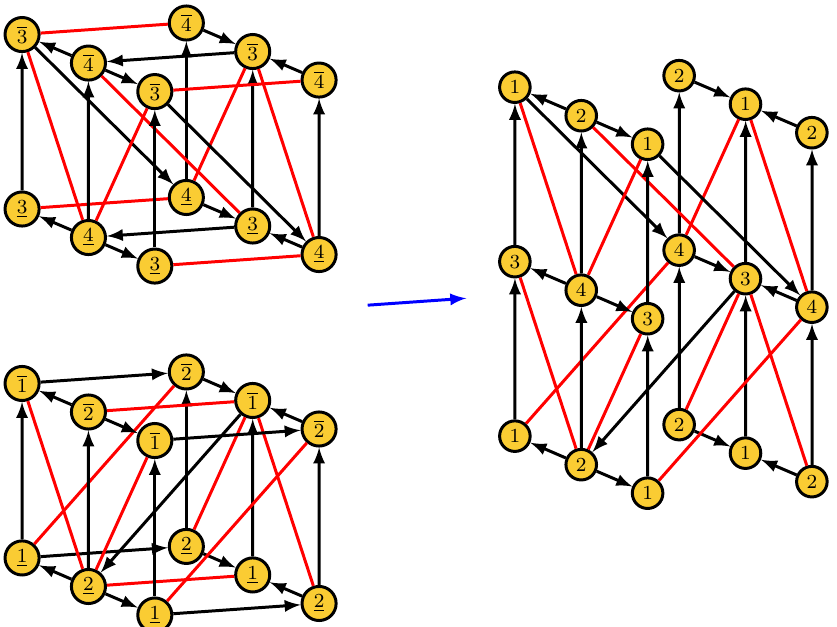
Figure 13. 3 d printing of a periodic quiver for H 4 using two conifold quiver